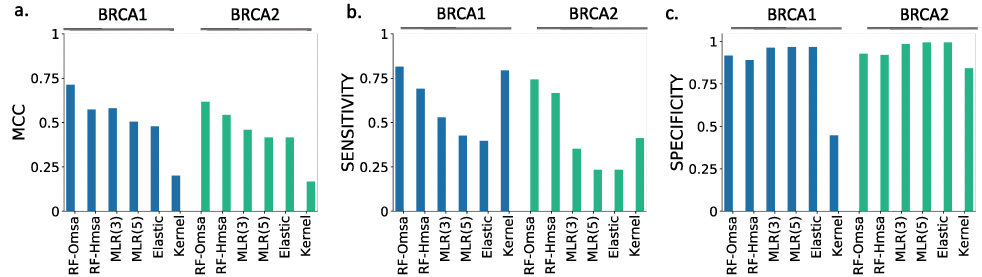
Figure 10. Performance comparisons between the RF and endophenotype-based pathogenicity predictions. This figure shows the values of three key descriptors of the success rate: ( a ) MCC, ( b ) sensitivity and ( c ) specificity. The results for BRCA1 and BRCA2 are colored in blue and green, respectively.